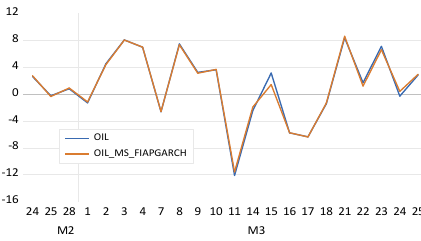
Figure 6. Oil, MS − FIAPGARCH. Figure 6. Oil, MS−FIAPGARCH. Figure 6. Oil, MS−FIAPGARCH.